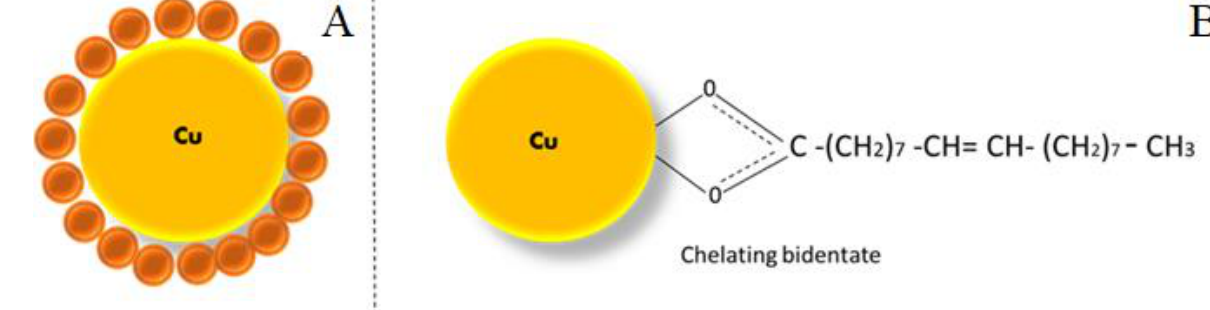
Figure 6. Operational prototypical of Cu particles with ( A ) oleic acid-coating. ( B ) Interface of the carboxylic group of oleic acid with copper atom.